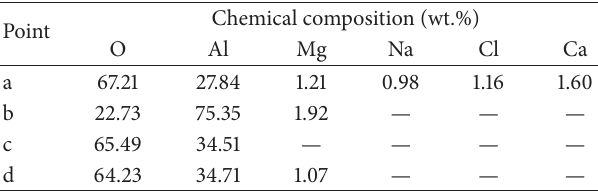
Table 3: Element contents ofcorrosionproducts marked inFigure 4 determined by